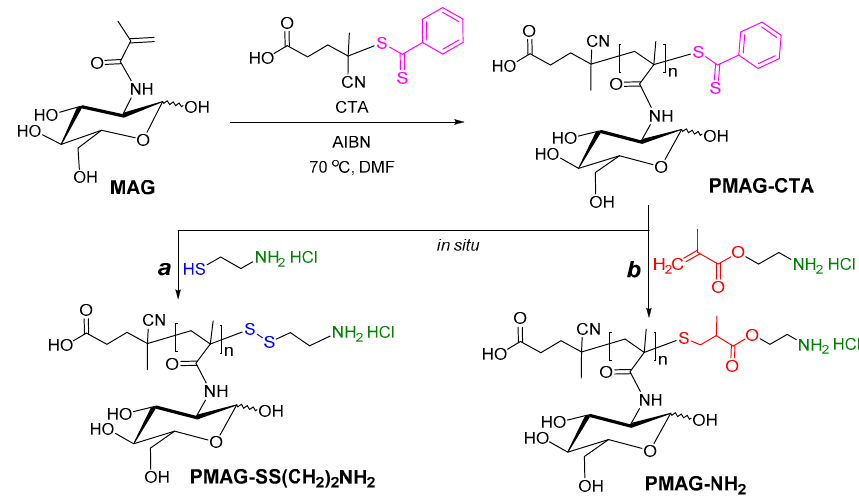
Figure 1. Scheme of RAFT-polymerization and modification of PMAG-CTA by: ( a ) 2-aminoethanethiol hydrochloride and ( b ) 2-aminoethyl methacrylate hydrochloride. 3.1.1. Post-Modification of PMAG-CTA by 2-Aminoethanethiol